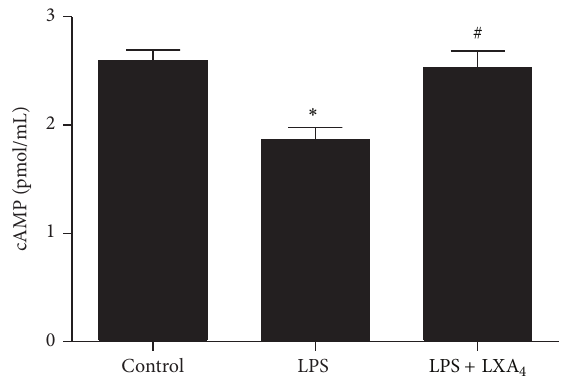
Figure 7: The effect of lipoxin A 4 on cAMP in ATII cells. The cells were treated with lipoxin A 4 (100nM) in the presence of LPS (1 𝜇 g/mL) for 1 hour. After incubation, the cells were harvested and intracellular cAMP was detected by Elisa Kits. Data were expressed as mean ± SEM for each group. ∗ 𝑃 < 0.05 versus control group, # 𝑃 < 0.05 versus LPS group. 𝑛 = 6 . LPS = lipopolysaccharide, LXA 4 = lipoxin A 4